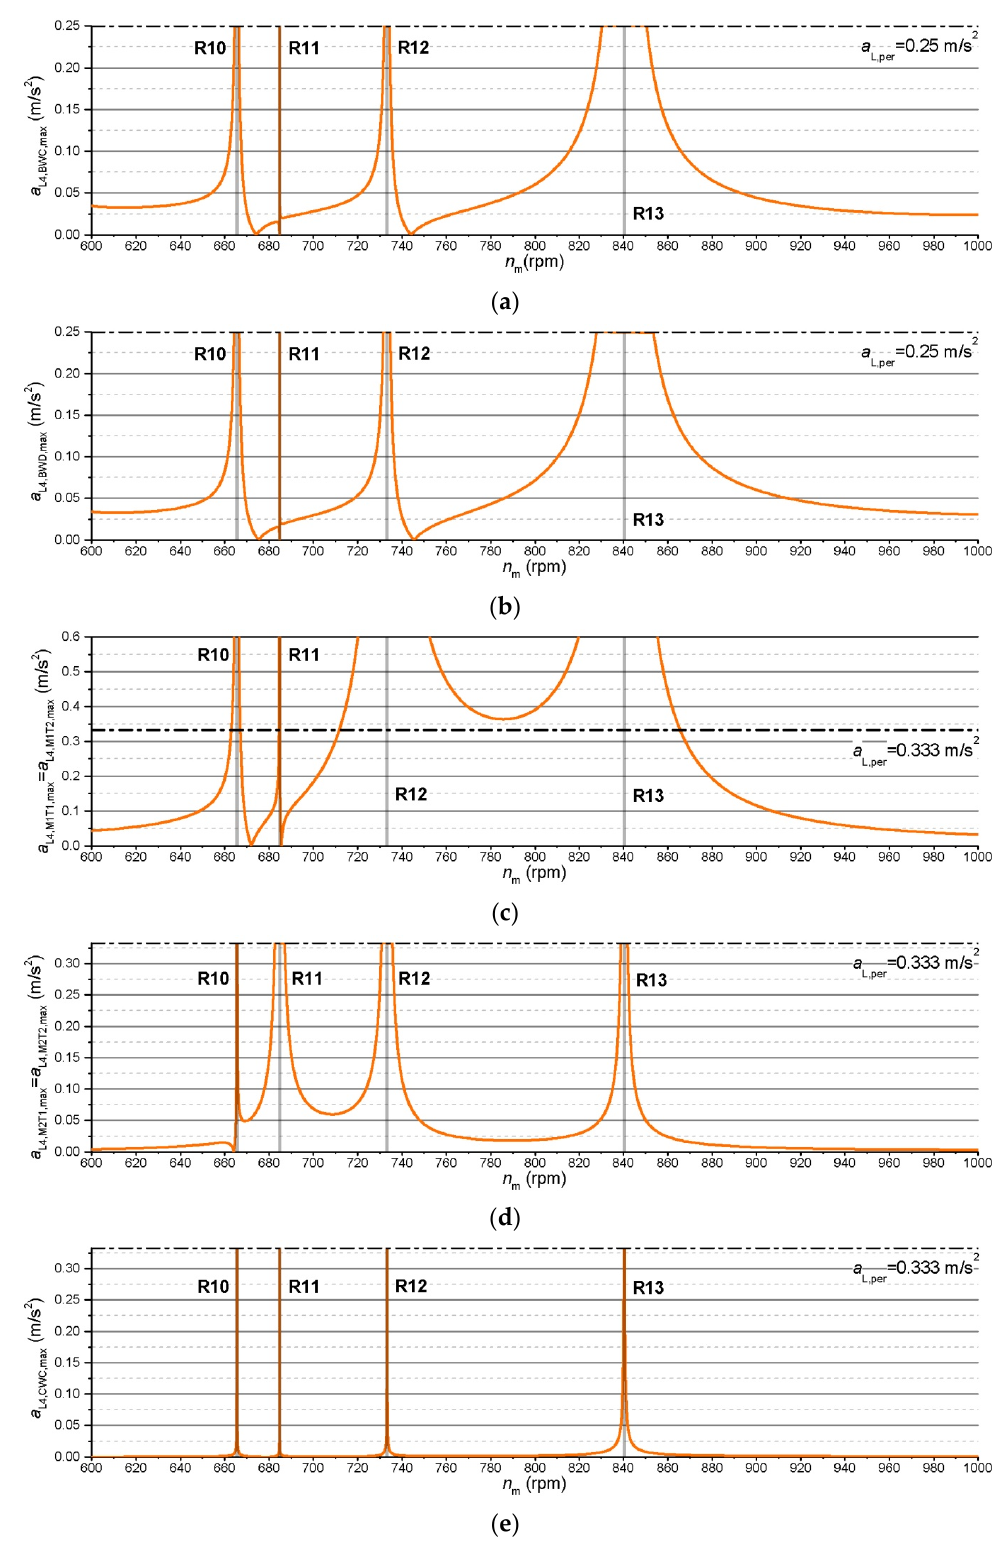
Figure 11. Response to the fourth harmonic of excitation—maximal lateral accelerations of the referent points of the slewing superstructure: ( a ) BWC; ( b ) BWD; ( c ) M1T1 and M1T2; ( d ) M2T1 and M2T2; ( e ) CWC.